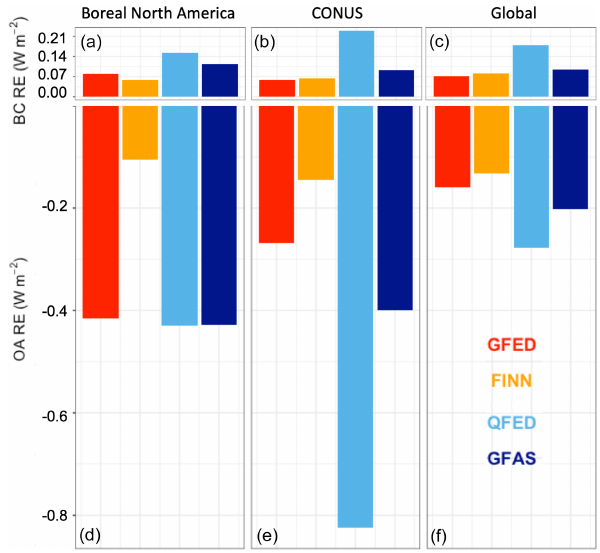
Figure 14. Top-of-atmosphere all-sky direct radiative effect of BB-only BC (a–c) and OA (d–f) averaged over 2012 in BONA, CONUS, and globally. GFED4s is shown in red, FINN1.5 is or- ange, QFED2.4 is light blue, and GFAS1.2 is dark blue (the size of BC versus OA panels is not to